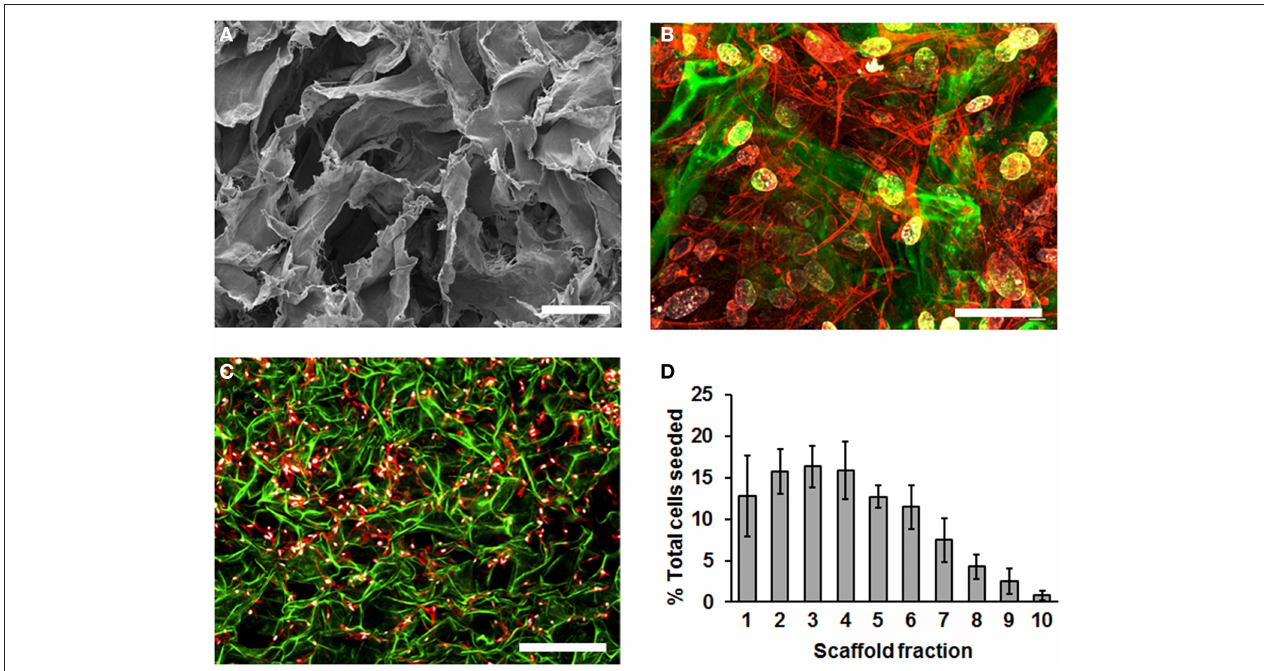
FIGURE 1 | SDR topology and distribution of MSC in them. (A) SDR as observed using scanning electron microscopy (SEM). SDR has a randomly folded laminar structure, which generates large spaces of 50–200mm in diameter. (B–D) 2.5 × 10 5 MSC were seeded in SDR, cultured for 3 days to allow maximum attachment and spreading, and fixed for staining as follows: Nuclei were stained with DAPI (blue), actin cytoskeleton is labeled with TRITC-coupled phalloidin and auto-fluorescence of SDR is shown in green. Although cell distribution appears relatively homogenous within the scaffold surface, 85% of cells were found concentrated in the upper half of the scaffold (C,D) . To quantify cell distribution, cell nuclei were counted within each z-section image and their distribution tabulated with respect to the scaffold fraction. Also using this z-stack analysis, we inferred an average seeding efficiency of 92%. Scale bar represents 0.1 µ m in (A) , 50 µ m in (B) , and 500 µ m in (C) .